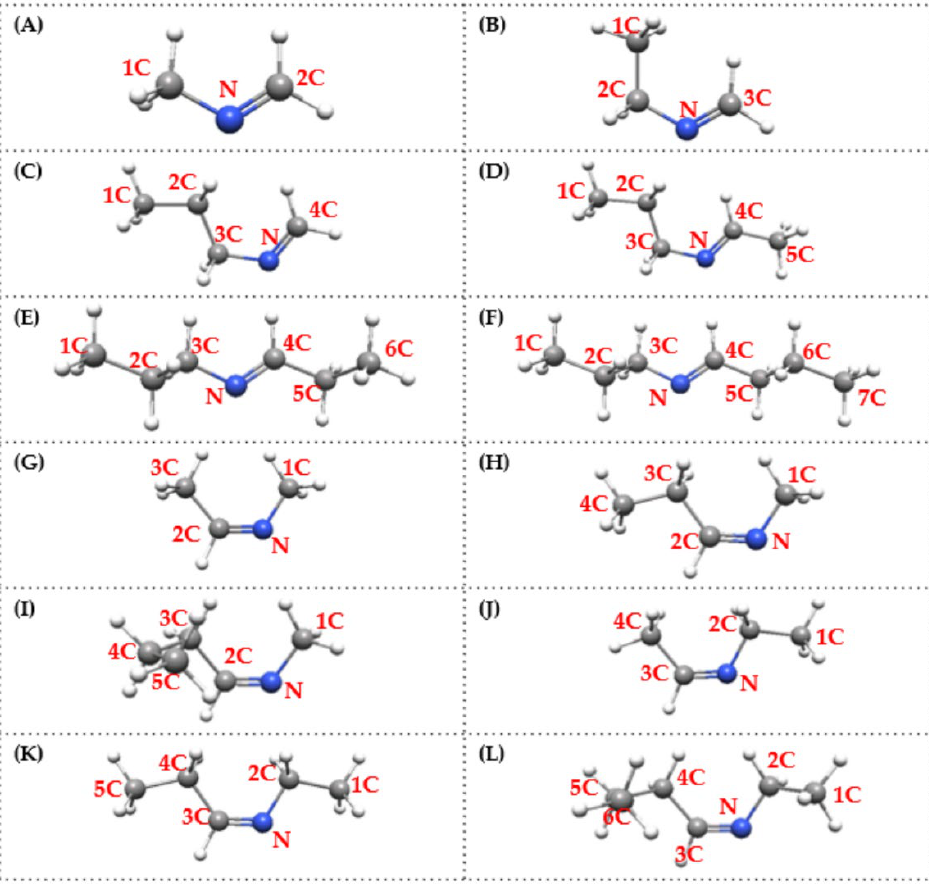
Figure 1. Optimized structure of studied aliphatic Schiff bases, ( A ) N-MMI, ( B ) N-EMI, ( C ) N-PMI, ( D ) N-PEI, ( E ) N-PP(1)I, ( F ) N-PB(1)I, ( G ) N-MEI, ( H ) N-MP(1)I, ( I ) N-MP(1)I, ( J ) (1Z)N-EEI, ( K ) (1Z)N-EP(1)I, ( L ) (1Z)N-EB(1)I.